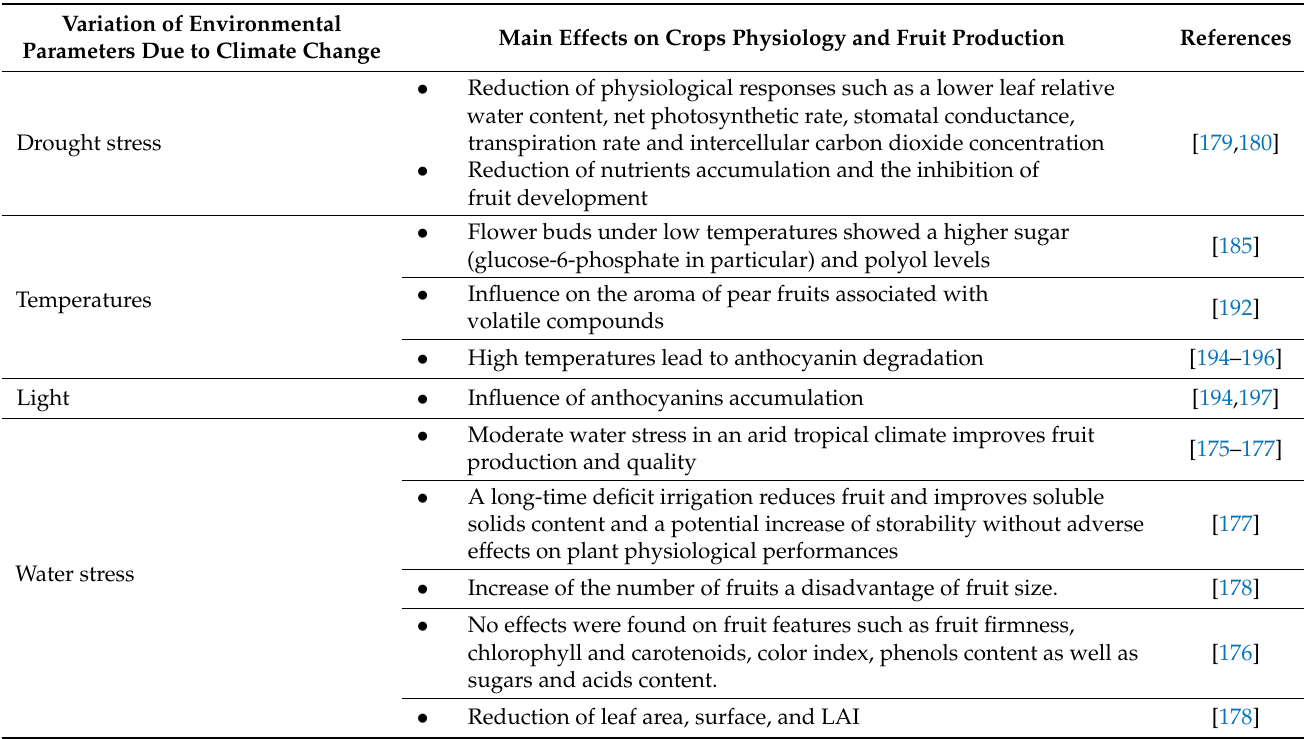
Table 13. Summary of principal effects of environmental conditions variation on pear